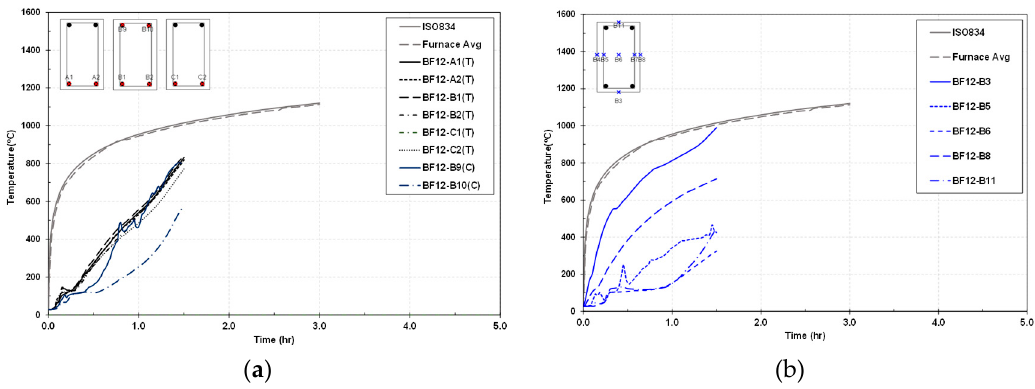
Figure 8. Temperature versus time relationship in the beam RF12. ( a ) Reinforcement; ( b ) concrete.